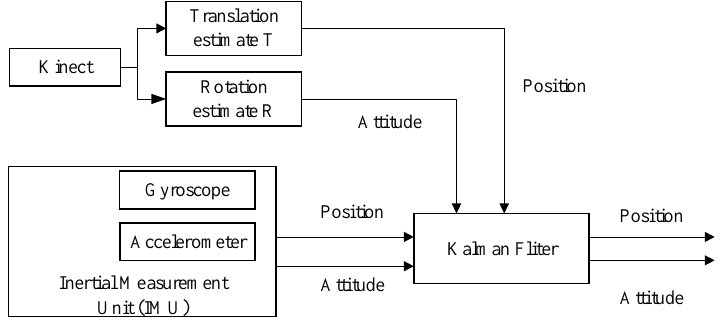
Figure 2. System and filter structure.